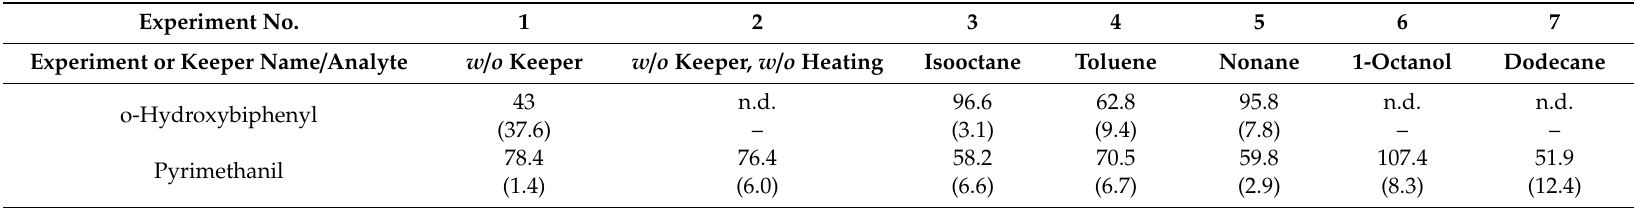
Table 5. Recoveries and RSDs (%) achieved in the o-hydroxybiphenyl and pyrimethanil evaporation experiments. Experiment